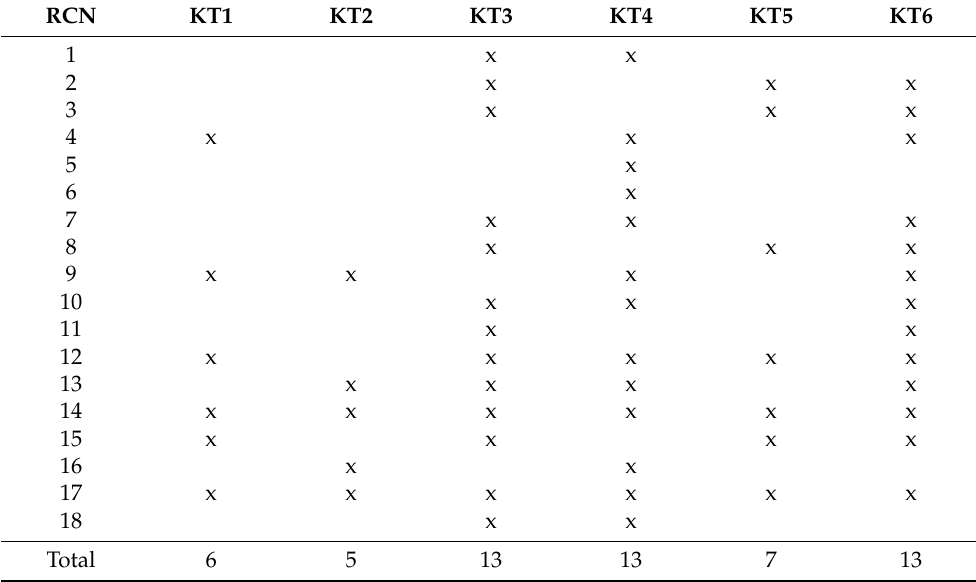
Table 3. Visual summary of relationship between raw coding numbers (RCNs) and distilled key themes (KTs). RCN KT1